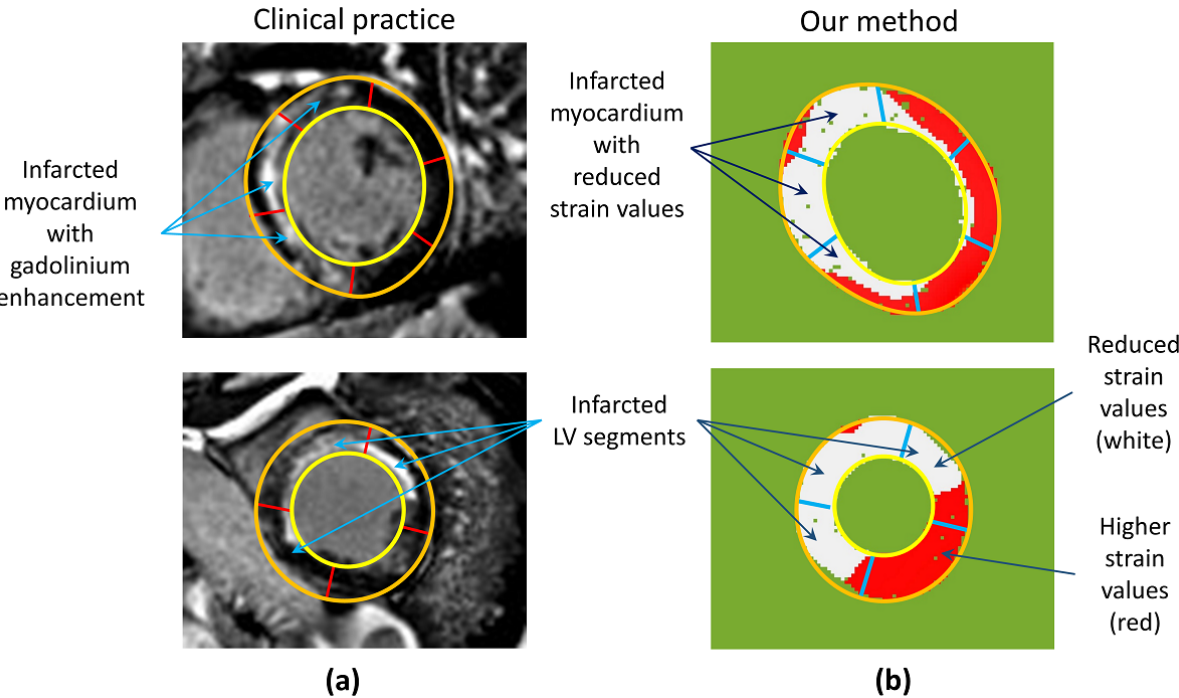
Figure 6. (a) LGE showing infarcted segments in white; (b) proposed CS-based analysis showing infarcted and healthy LV segments in white and